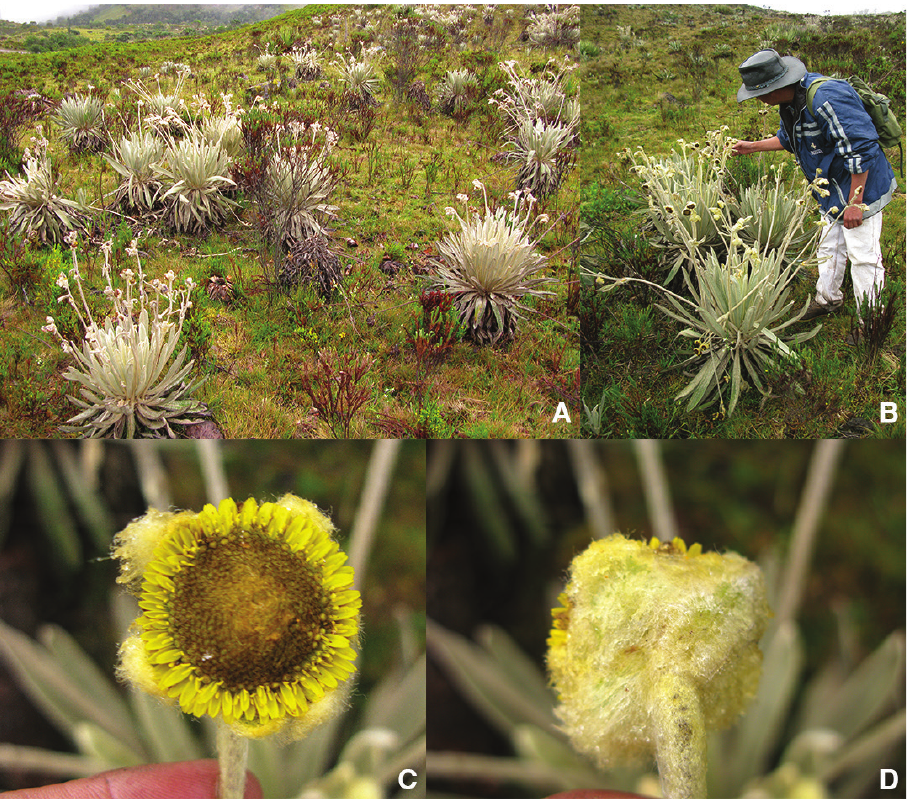
Figure 1. Espeletia praesidentis : A habitat, showing a large population B holotype collection ( M. Di- azgranados & L.R. Sánchez 3865 ), with stemmed rosette habit and very long capitulescences C frontal view of capitulum D dorsal view of